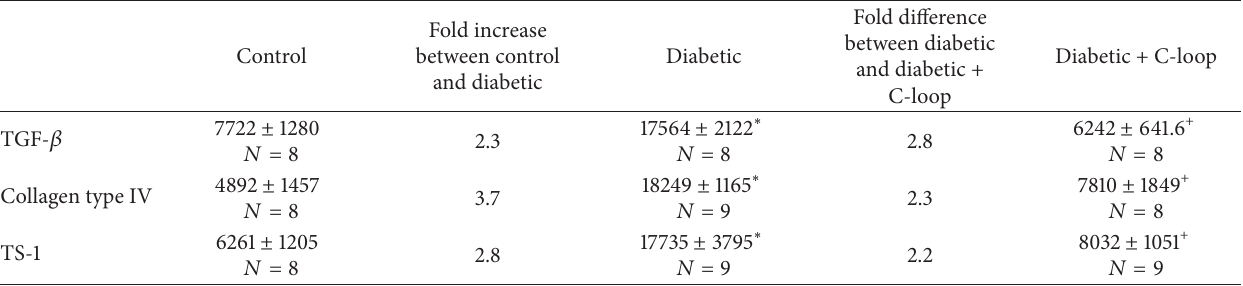
Table 2: Analysis of fibrotic proteins in kidney